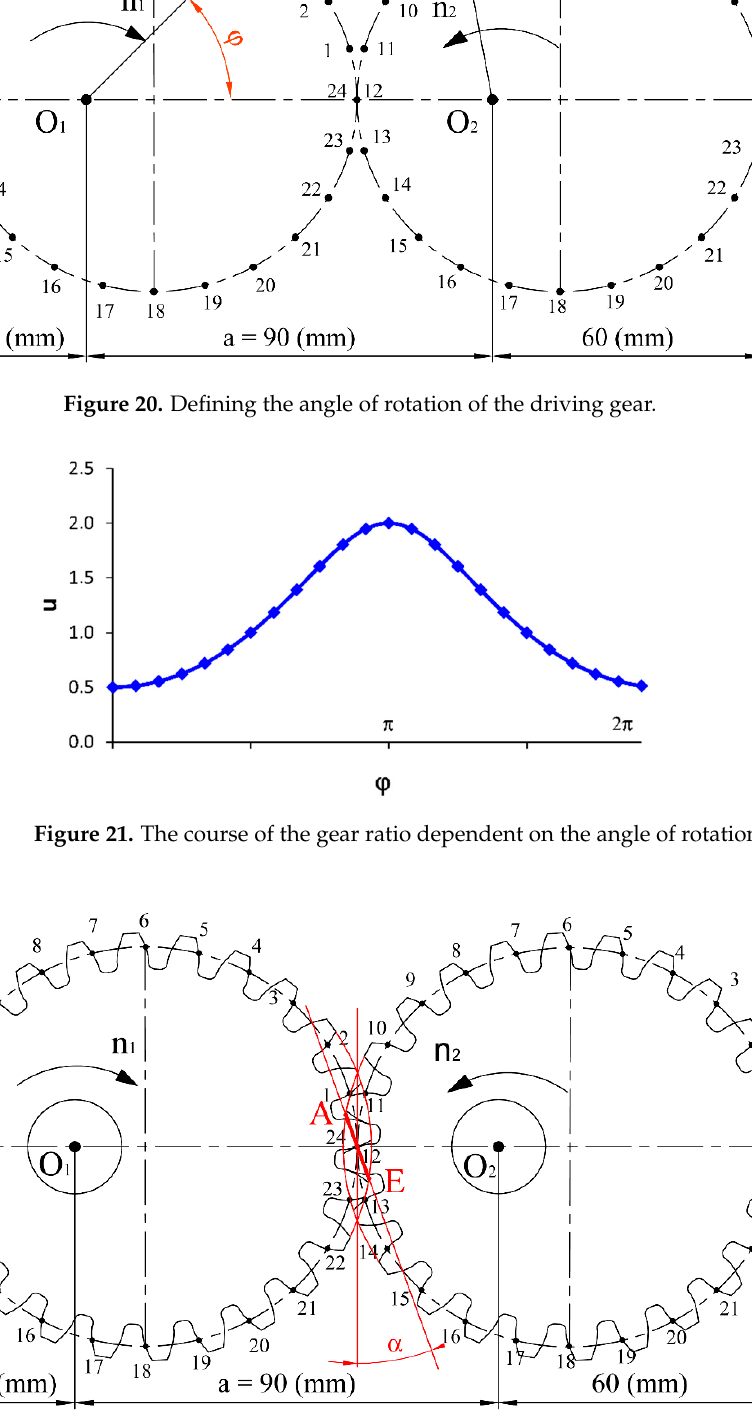
Figure 23. The course of changing gear ratio of the meshing teeth pair, driving wheel tooth num- ber 24 and drive wheel tooth number 12 . The standard spur gears have the constant (same) contact ratio for all teeth of mesh- ing. The value of the contact ratio (CR) of meshing for spur gears is in the range 1 < CR < 2. This is not the case with the designed elliptical gearing. The values of length of meshing line AE and contact ratio for elliptical and spur gearing are shown in Table 2 and Figure 24. Table 2. Length of part of contact AE and contact ratio. Elliptical Gearing